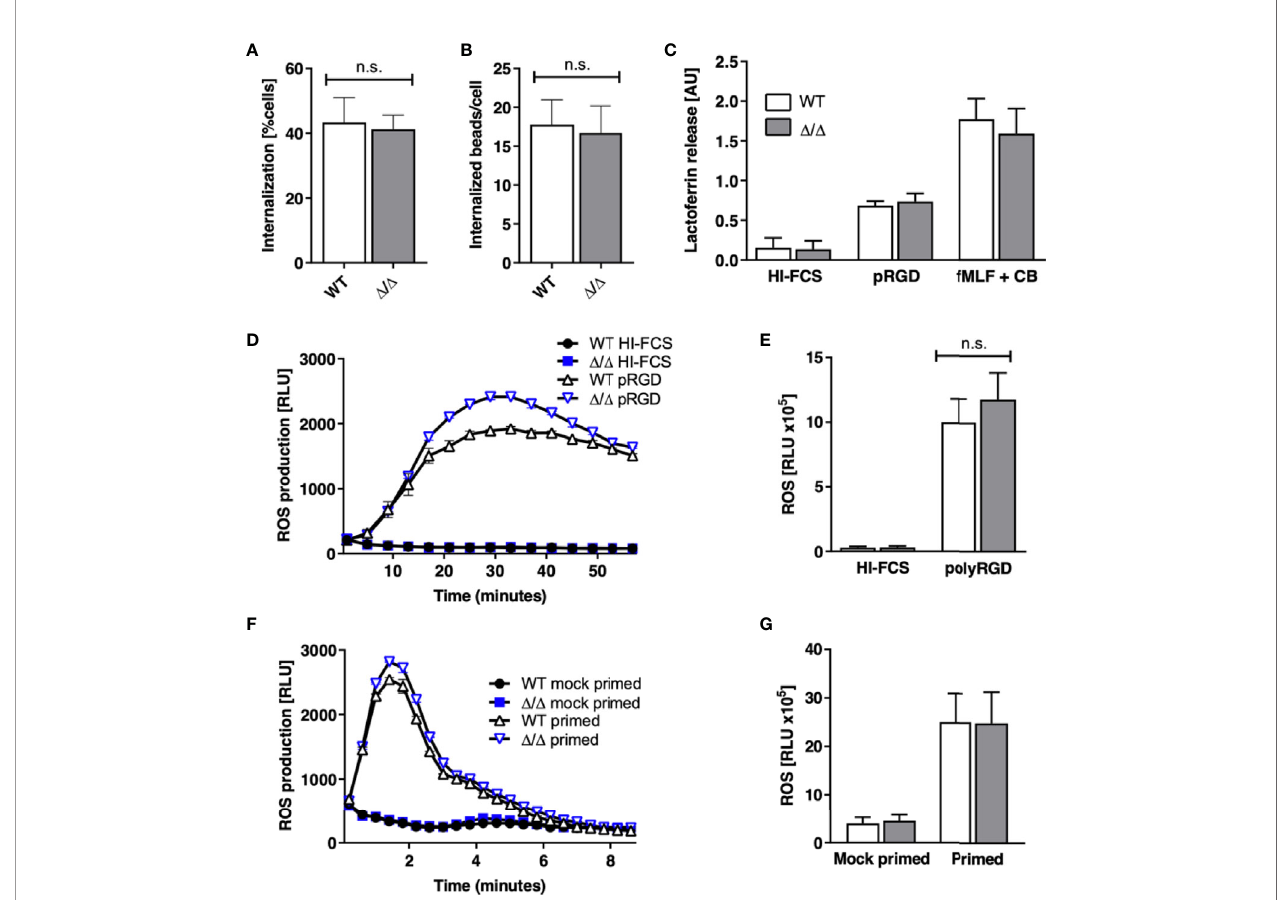
FIGURE 5 | SHIP2 is dispensable for ROS production, degranulation and phagocytosis. Bone marrow derived wild-type (WT) and Ship2 D / D ( D / D ) neutrophils were assayed for (A, B) phagocytosis of rabbit IgG-opsonized latex beads. Results obtained in 5 separate experiments are presented as bar graphs. (A) Percentage of cells that had internalized beads; (B) average number of beads internalized per cell. (C) Degranulation. Cells were stimulated by being plated onto plastic blocked with heat inactivated (HI) FCS or coated with the pan integrin ligand poly-Arg-Gly-Asp (pRGD), or stimulated with fMLF in the presence of cytochalasin B and lactoferrin release was measured by ELISA. Means ± SEM obtained from 4 separate experiments are integrated in this experiment. (D – G) ROS production, with neutrophils stimulated by being plated onto integrin ligands (D, E) or with the soluble stimulus fMLF (F, G) . (D, F) Representative experiments and (E, G) accumulated light emission (mean ± SEM) from 4 separate experiments are shown. Pairwise comparison between wild-type and Ship2 D / D neutrophils were not signi fi cant under any of the conditions tested. n.s., not signi fi